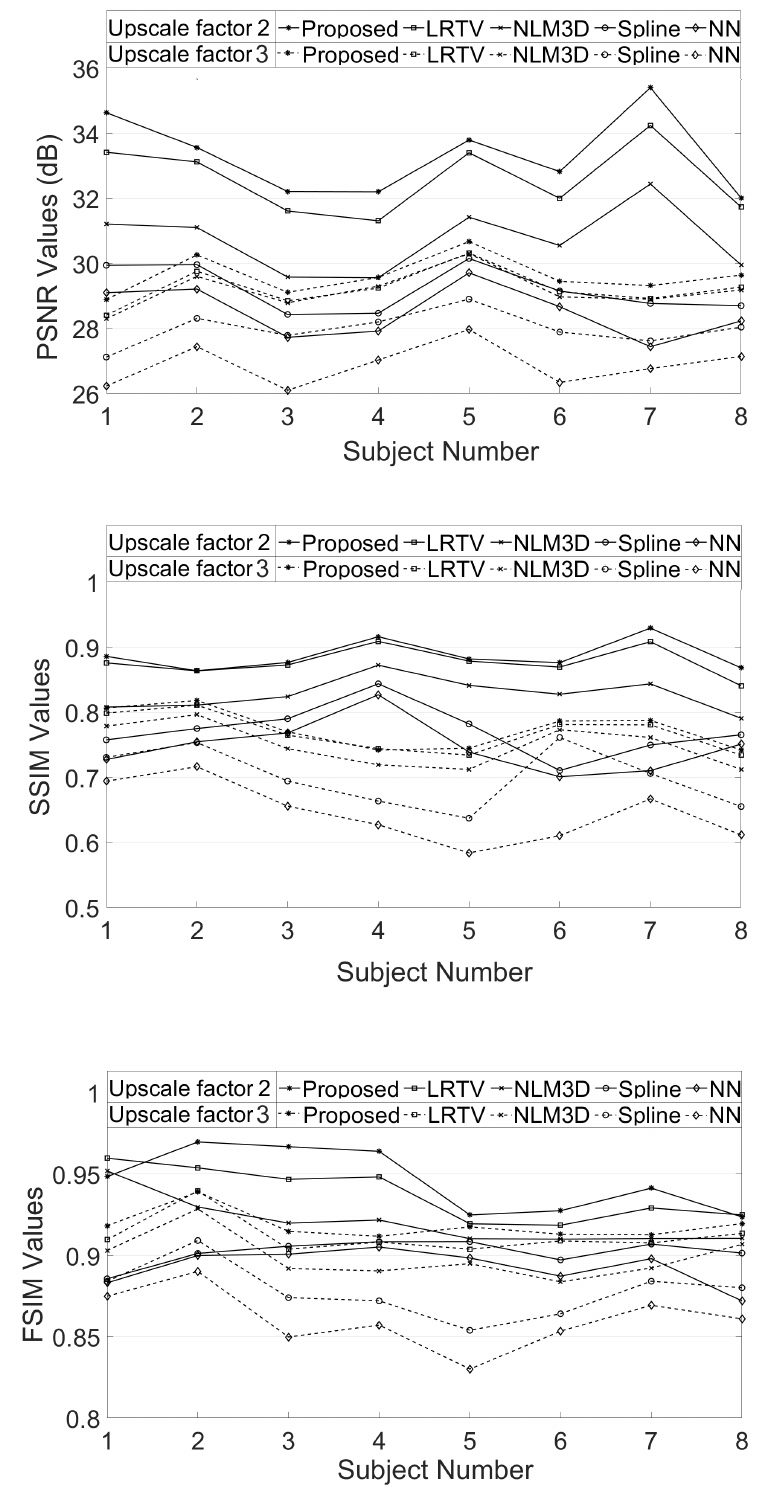
Figure 10. Demonstration of PSNR, structural similarity index (SSIM) and feature similarity index metric (FSIM) values obtained for super resolution of eight MR image volumes by upscale factors 2 and